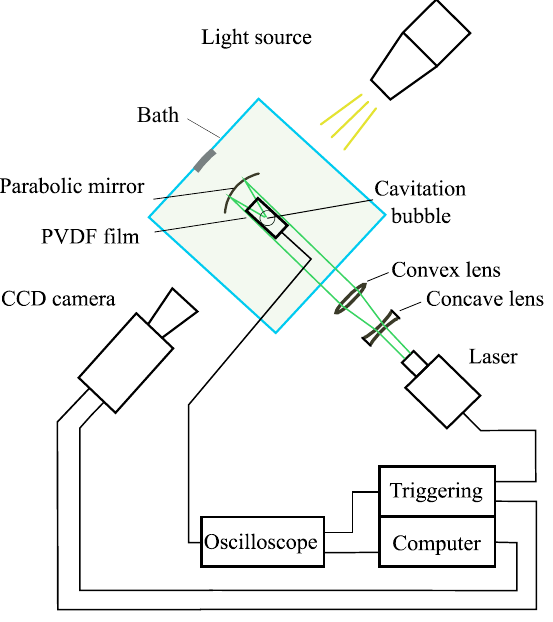
Fig. 1. Experimental setup used in the investigation of the cavitation bubble collapse.